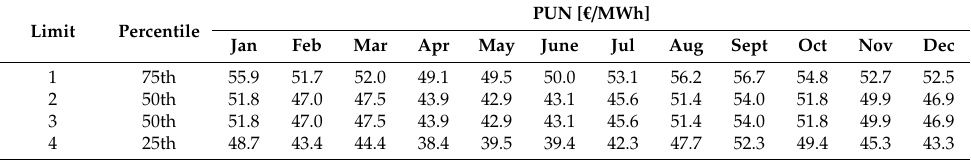
Table A4. PUN Index thresholds limit for calculations over the non-working days.